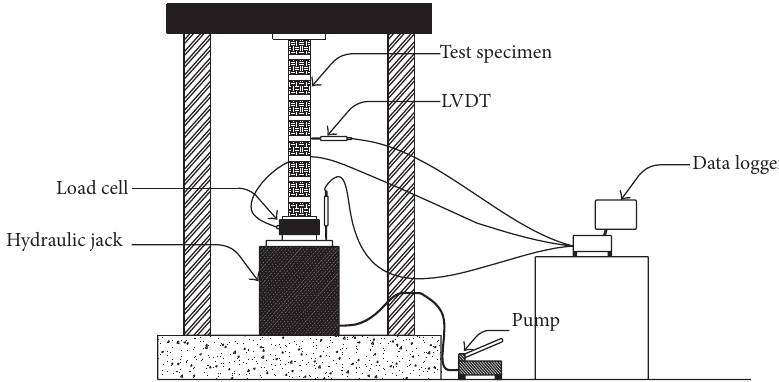
Figure 3: Experimental